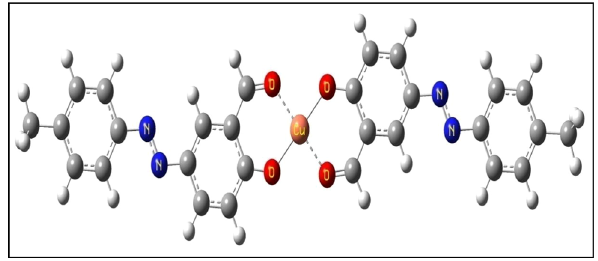
Figure 2: Optimized structure of Complex 1.